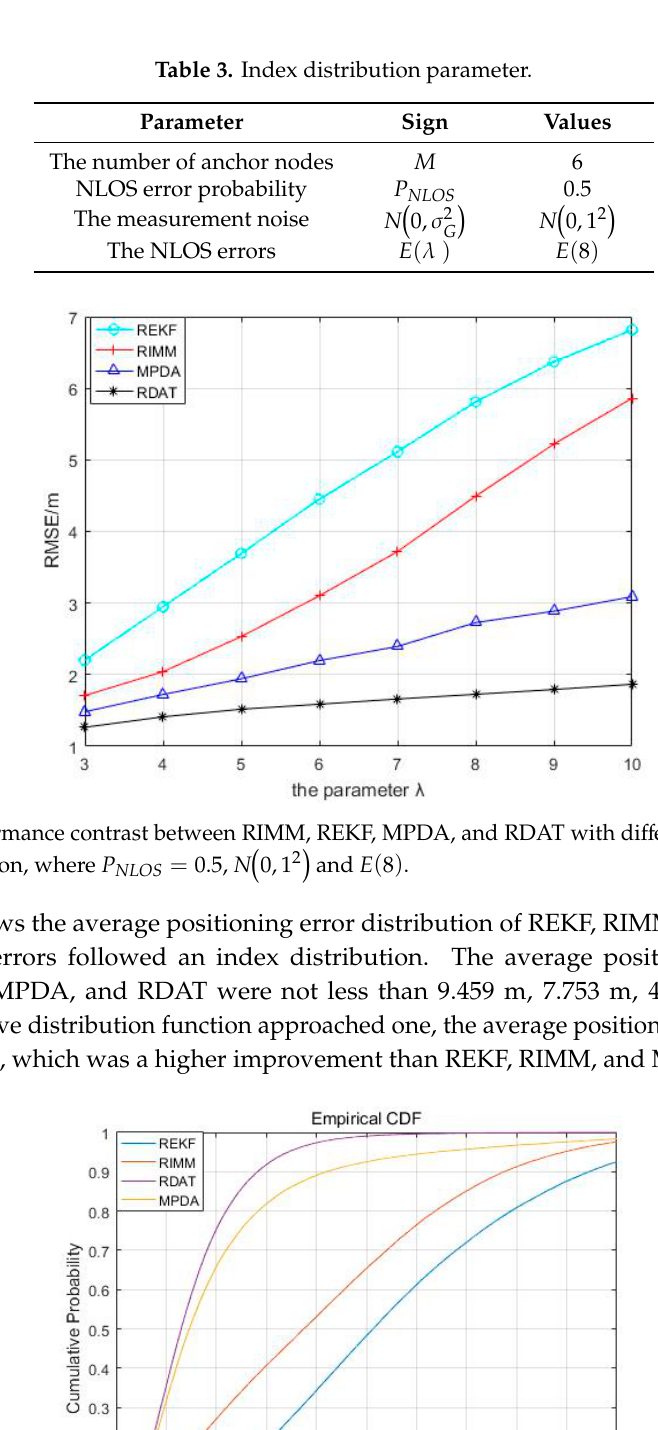
Figure 10. The CDF result of the localization error.